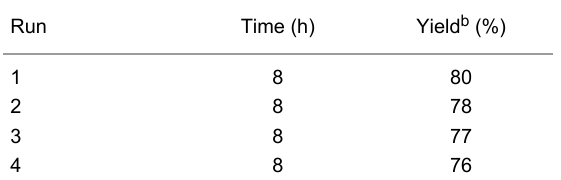
Table 5: Recycle studies of nano-CuO for C-arylation reaction a